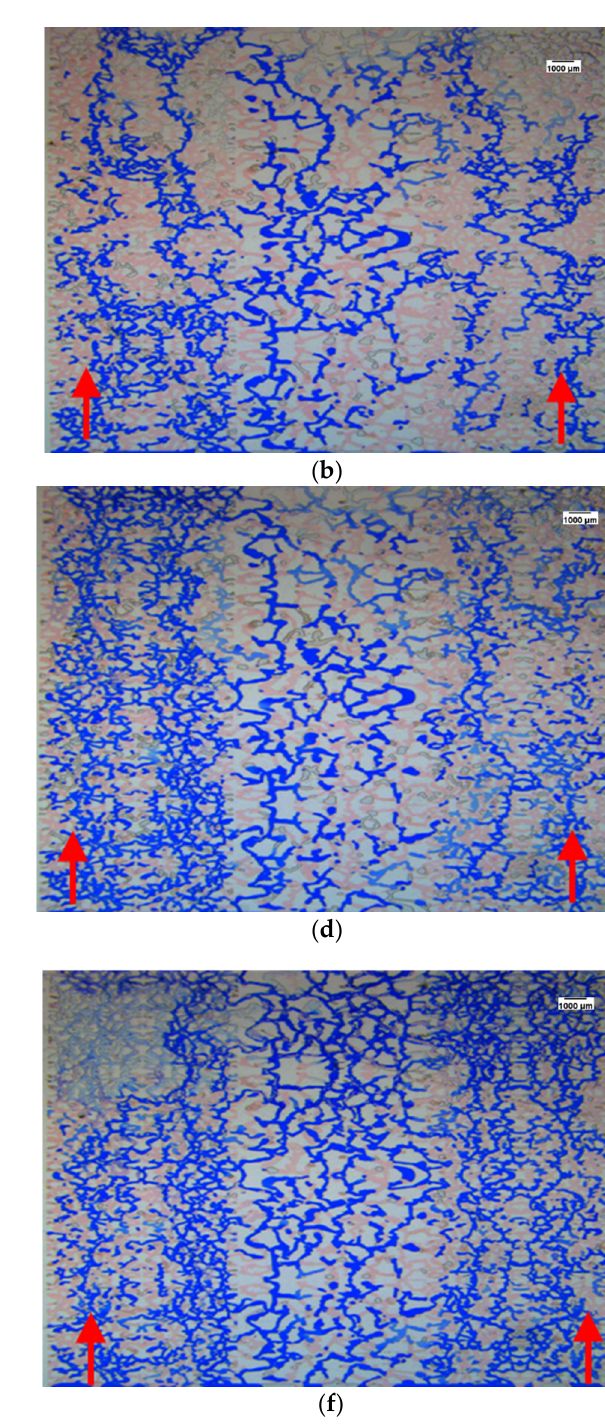
Figure 14. The process diagram of the homogeneous model gel-emulsifier compound water shutoff process. ( a ) The first gel injection, ( b ) the second water invasion, ( c ) the first emulsifier injection, ( d ) the third water invasion, ( e ) the second gel injection, ( f ) the fourth water invasion.